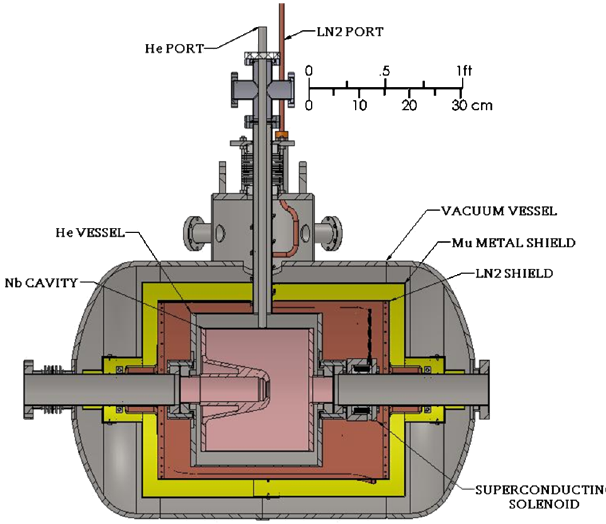
FIG. 2. Cross section of the cavity without the cathode stalk or coupler installed.